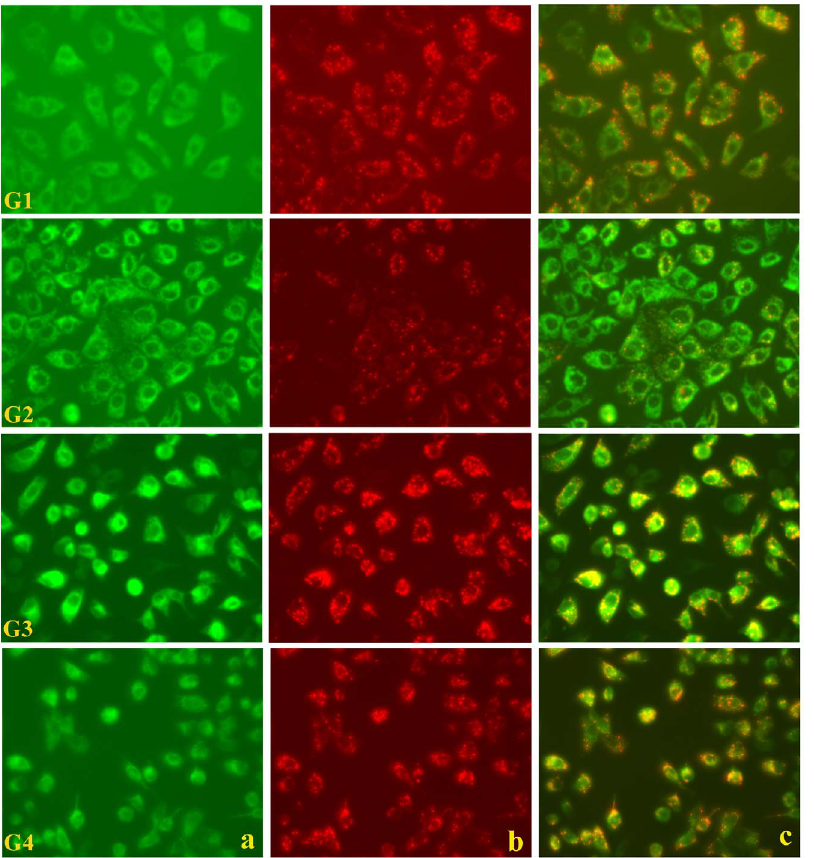
Figure 4. C-phycocyanin protects cellular mitochondrial membrane potential from oxalate-induced ROS. Integrity of mitochondrial membrane potential in MDCK cells investigated by a mitochondrial potential-sensitive dye, JC-1, showing normal stippled spots of bright red fluorescence (G1 a–c ). The numbers (viz. a–c) in the panels represents the red, green and merged channel fields observed respectively. Oxalate- exposed MDCK cells observed later (G2 a–c ) shows the absence of characteristic red fluorescence. Cells pre-treated with CP and oxalate showing the re-appearance of red fluorescence spots following normalization of mitochondrial potential (G3 a–c ). This confirms that CP could protect against mitochondrial membrane oxalate induced-ROS and does not itself affect the mitochondrial potential. Cells treated with CP alone show a normal picture (G4 a–c ). G1: Control; G2: Oxalate; G3: Oxalate + CP; G4: CP alone.